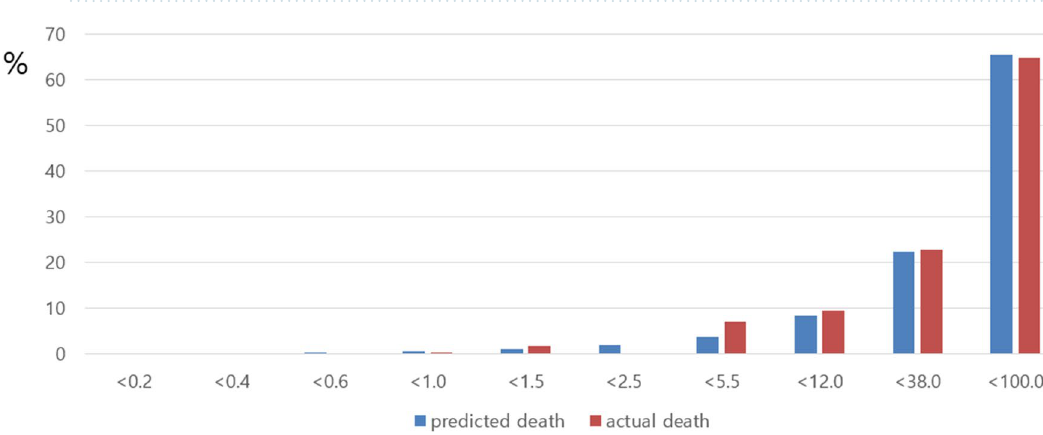
Figure 1. Probability of Predicted and Actual Deaths in total set of participants.